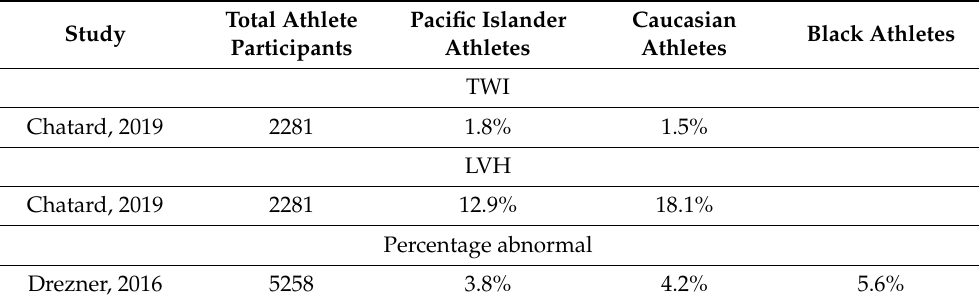
Table 8. Proportions of ECG changes in Pacific Islander athletes compared to